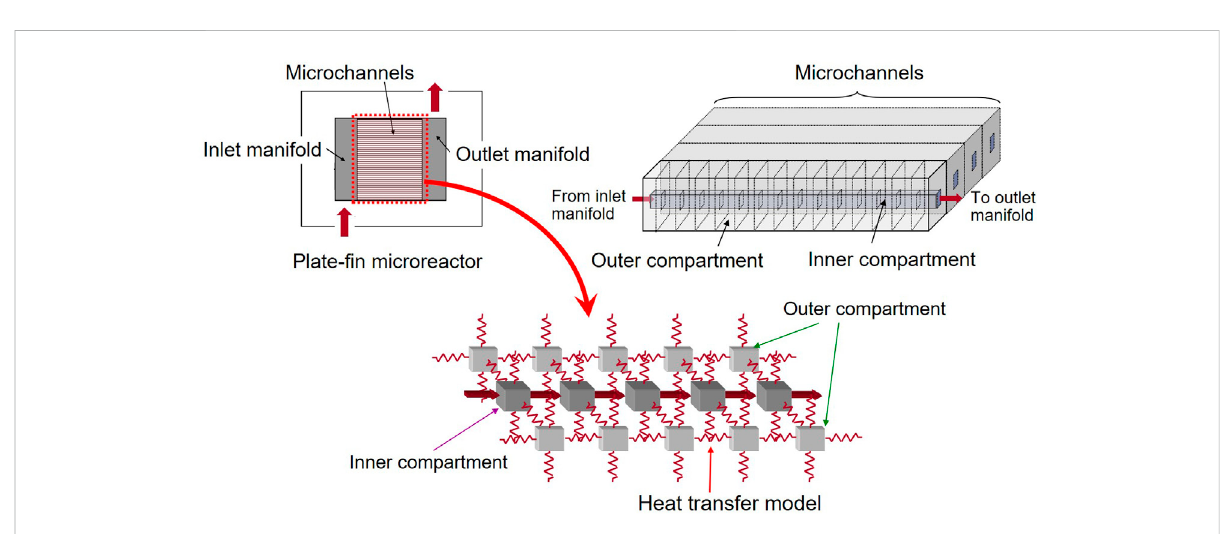
FIGURE 3 Thermal compartment model.